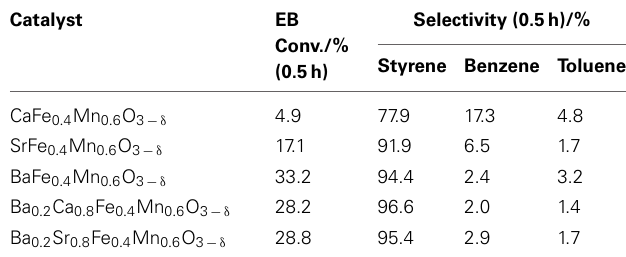
Table 1 | EB conversion and selectivity to products for EBDH over perovskite